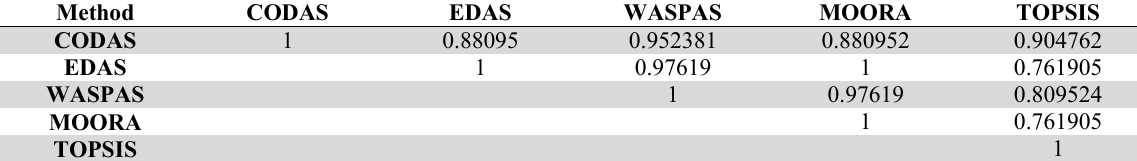
Spearman rank correlation coefficient between different methods Method CODAS EDAS